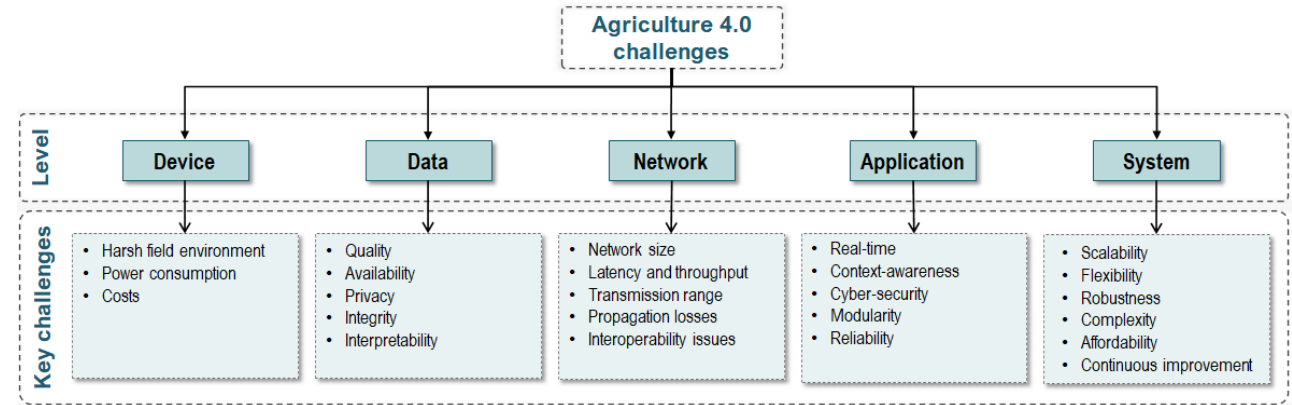
Figure 8. Some of the key challenges to be addressed in Agriculture 4.0 divided into five main levels, namely: device, data, network, application and